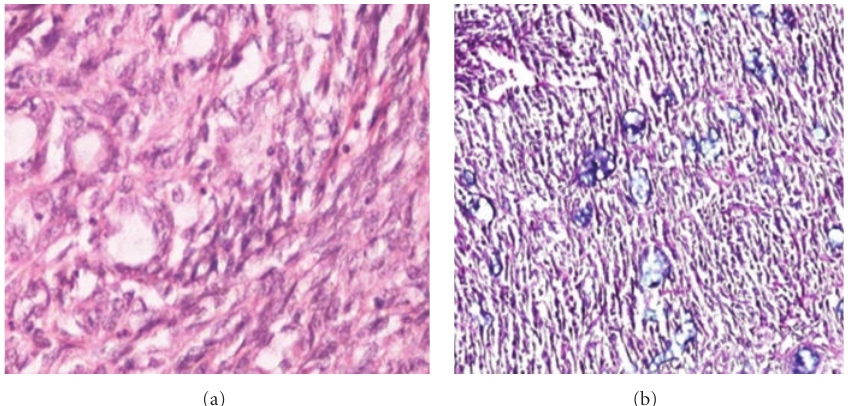
Figure 4: Photomicrographs highlighting the glandular features of the tumour (a) with Alcian blue positivity in the lumen (b) ( × 400, H&E; × 100, Alcian blue, resp.).